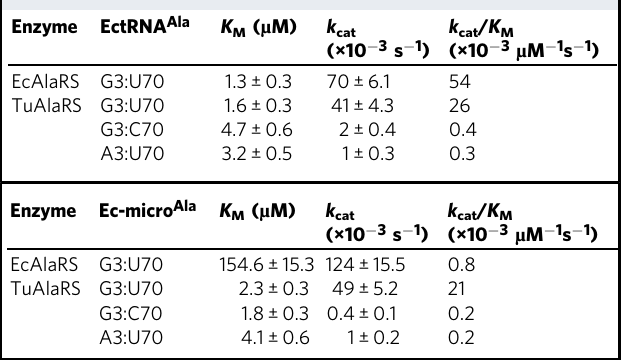
Table 1 Kinetic parameters for aminoacylation of EctRNA Ala and Ec-micro Ala by EcAlaRS and